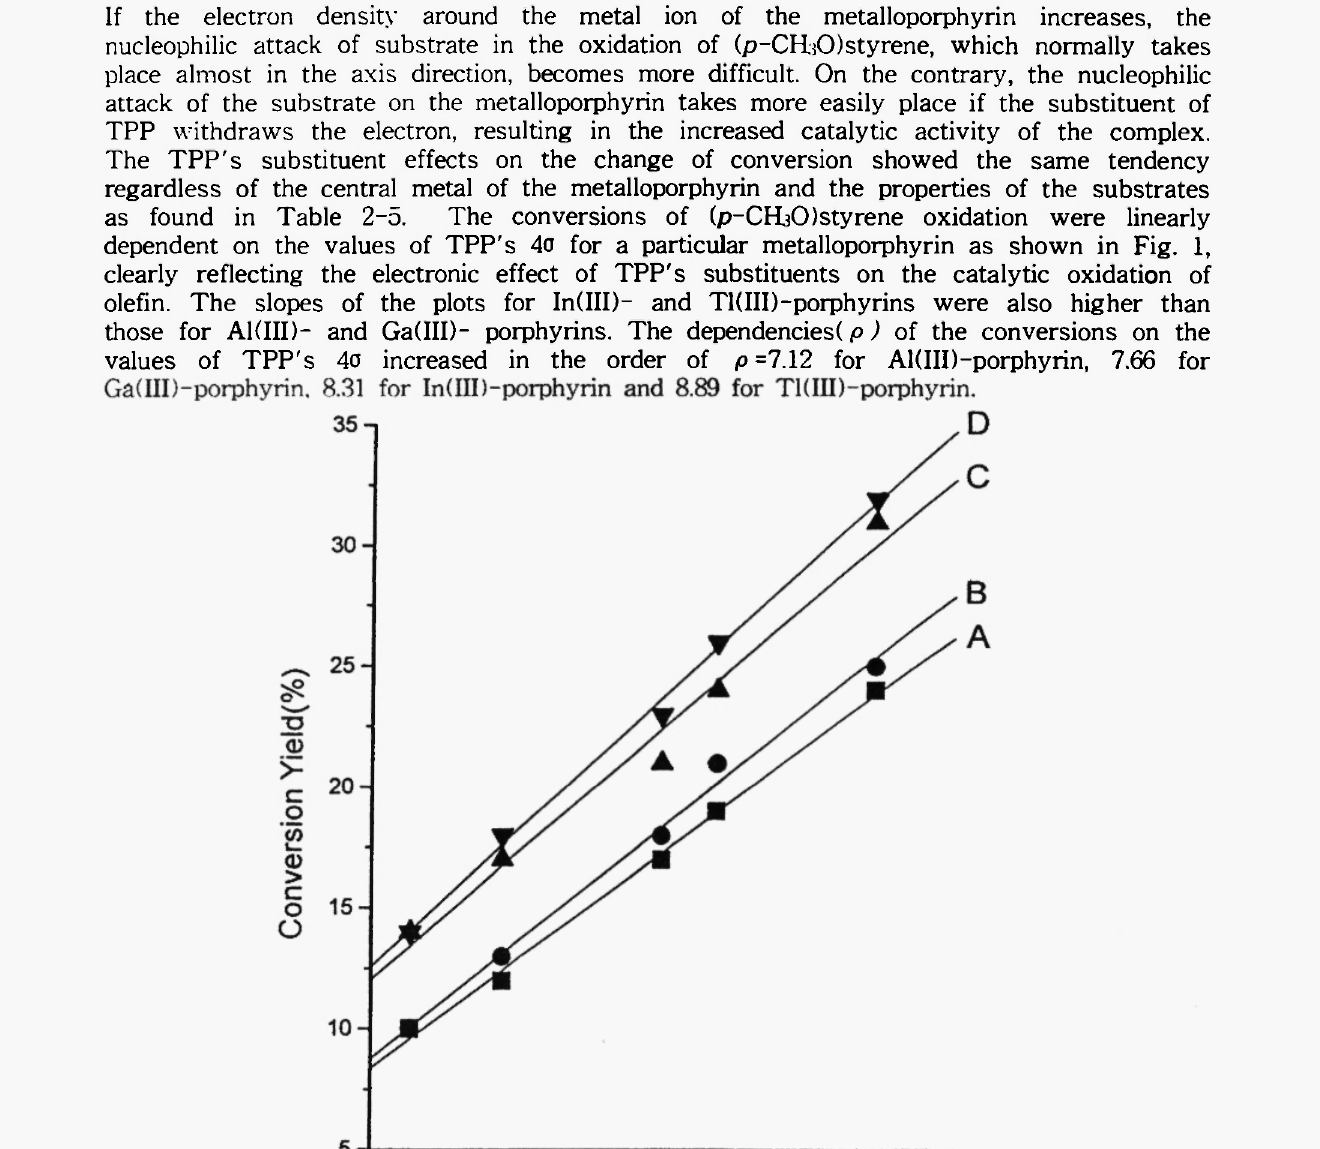
Fig. 1. Plots of conversion yields vs the Hammett 4σ constants of porphyrins in the (p-CH 3 0)styrene oxidation catalyzed by metalloporphyrins at25*C. A ( ·) for Ätioporphyrin: p(slope) = 7.12, B ( ·) for Ga(lll)-porphyrin: p=7.66, C(A) for In(lll)- porphyrin: p= 8.31 and forTI(lll)-porphyrin: p=